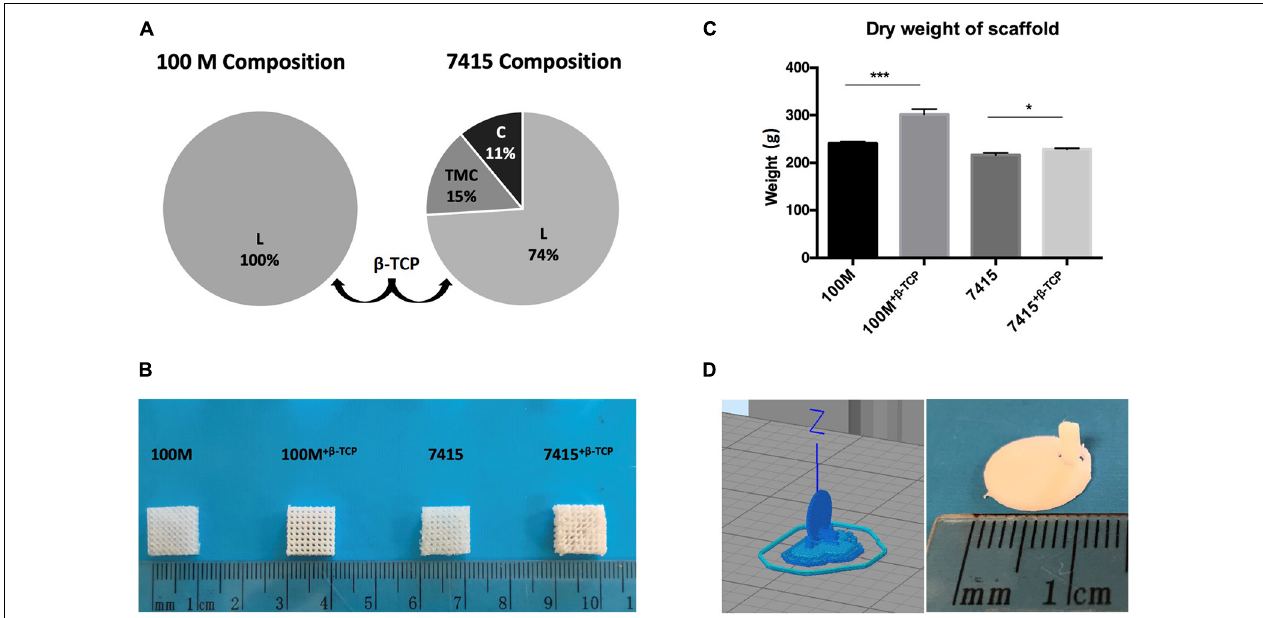
FIGURE 1 | Scaffold fabrication. (A) Illustrated charts representing the total composition of 100M scaffolds and 7415 scaffolds. (B) Scaffolds professional images. Marker represent 1 cm dimensions. (C) Graph showing the differences in the dry weights of materials after printing, n = 3, error bars represent ± SD, and * P -value < 0.05, *** P -value < 0.001. (D) Circular scaffold design for testing surface characteristics of materials.